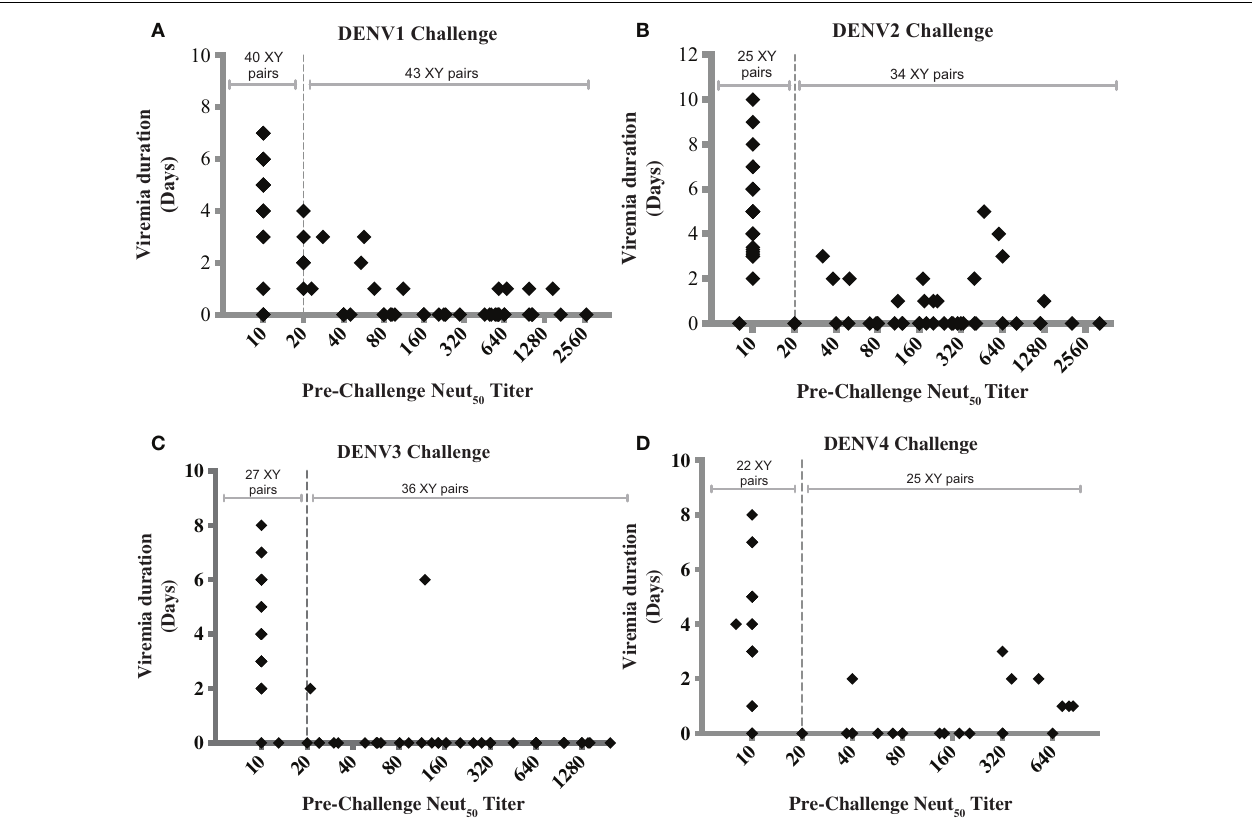
Data were combined based on the challenge virus serotype into graphs (A–D) , corresponding to serotypes 1–4, respectively, regardless of vaccine type or whether it was monovalent or tetravalent. Dotted line indicates a Neut 50 titer of 20.Titers below the limit of detection were given a value of 10, whether the limit of detection was 10 or 20.The number of XY pairs with Neut 50 titers <20 or ≥ 20 are indicated at the top of each graph. Pearson correlation coefficients ( r ) were − 0.4453, − 0.3367, − 0.4182, and − 0.3063 for graphs (A–D) ,